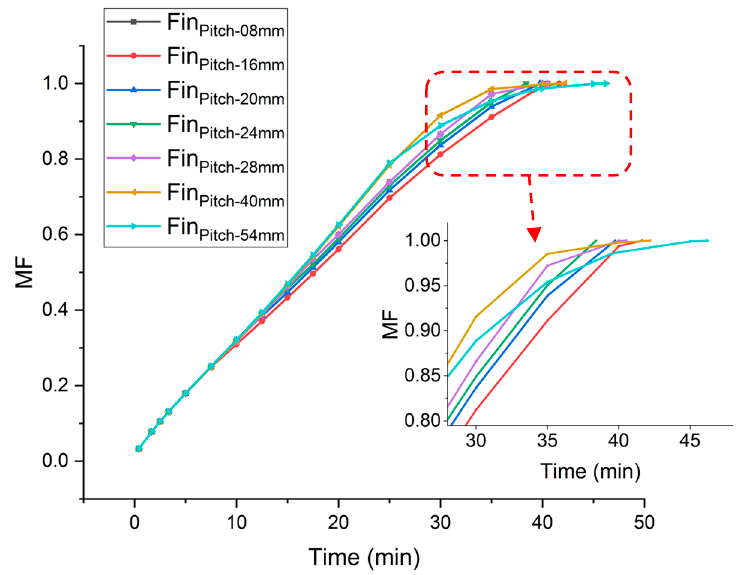
Figure 7. Time vs Melt Fraction at different pitch.